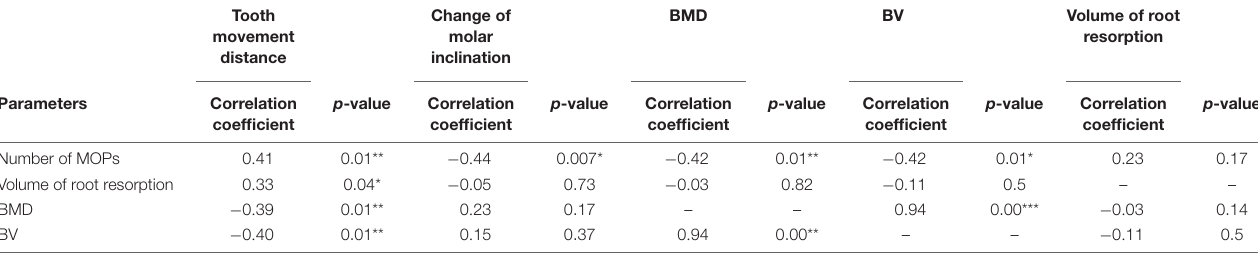
TABLE 1 | Correlation analysis of number of MOPs, volume of root resorption and Bone mineral density, and Bone volume. Tooth